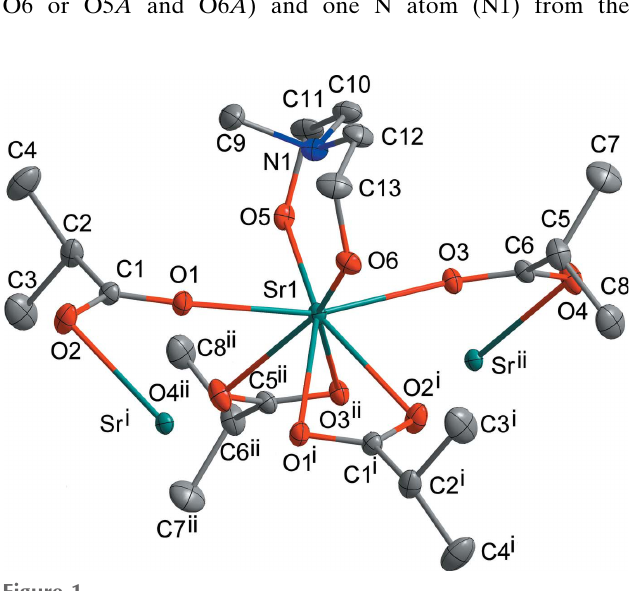
Figure 1 Ellipsoid plot of the monomeric unit of I with displacement ellipsoids at the 30% probability level for all non-H atoms. H atoms are omitted for clarity. Color code: Sr teal, C gray, N blue, O red. Disordered atoms are